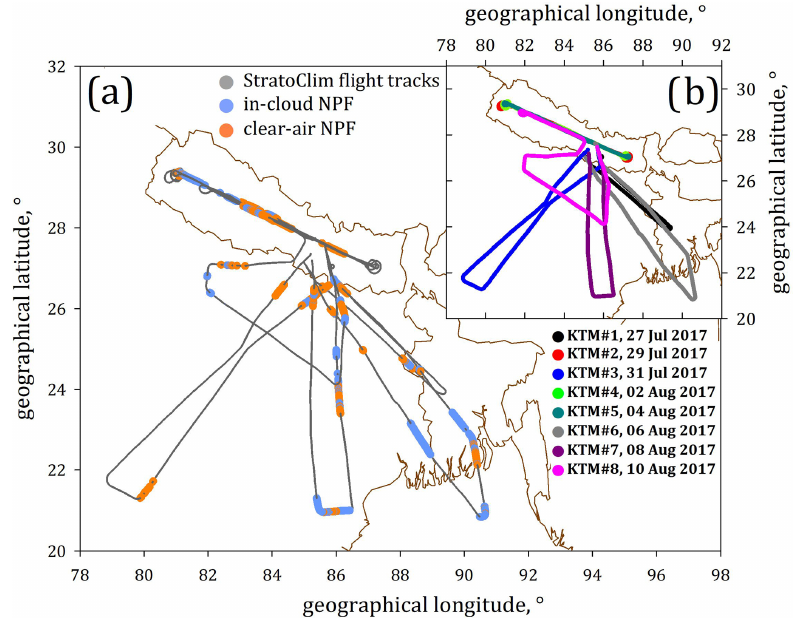
Figure 1. The flight patterns of the M-55 Geophysica during StratoClim 2017 over the Indian subcontinent. New particle formation (NPF) encountered in clear air along the flight tracks is indicated by orange colour in the main panel (a) . All NPF events coinciding with the detection of cloud (ice) particles are coloured in blue. The general perspective (b) exhibits the patterns of the eight StratoClim flights over Nepal, north-eastern India, Bangladesh, and the Bay of Bengal. For more details, see Table